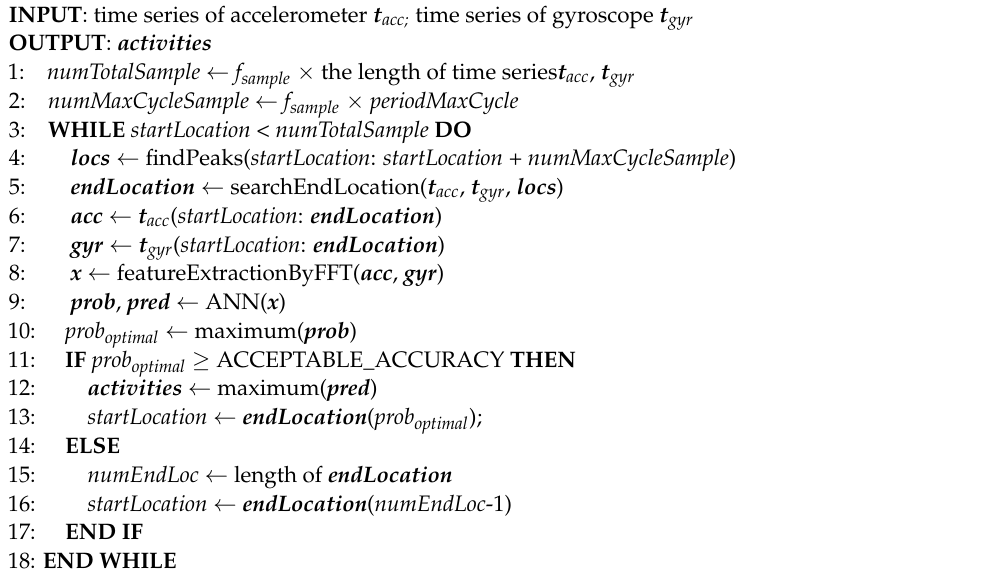
Algorithm 1. Human Lower Limb Motion Live Detection